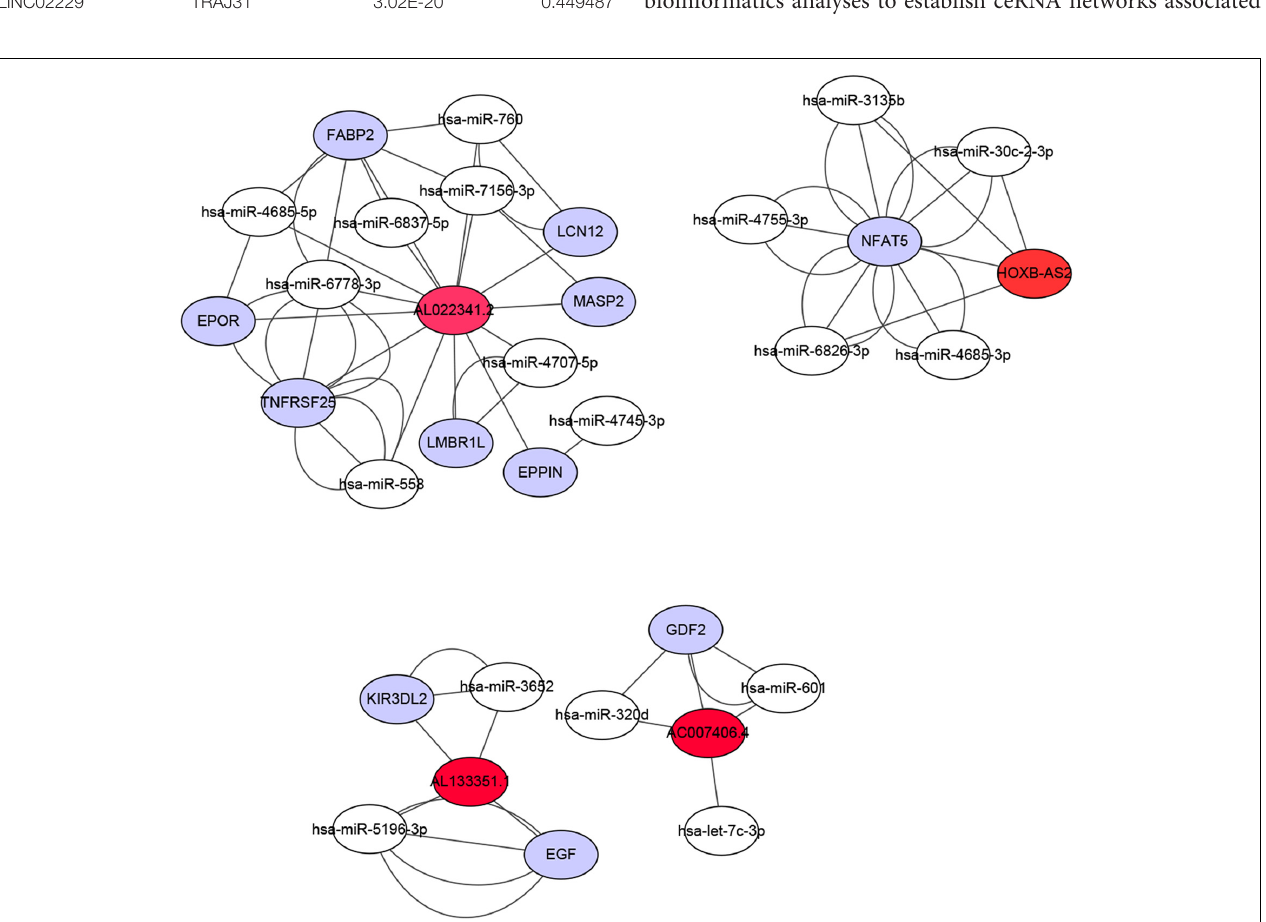
and mRNA. The mechanism of this RNA-RNA interaction is